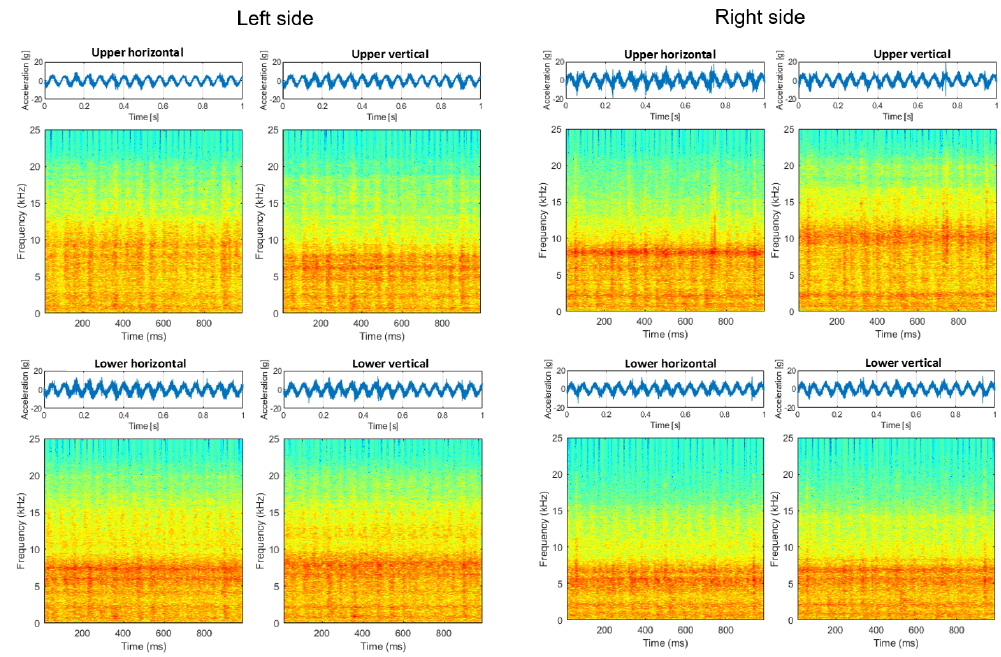
Figure 9. Signals and spectrograms after